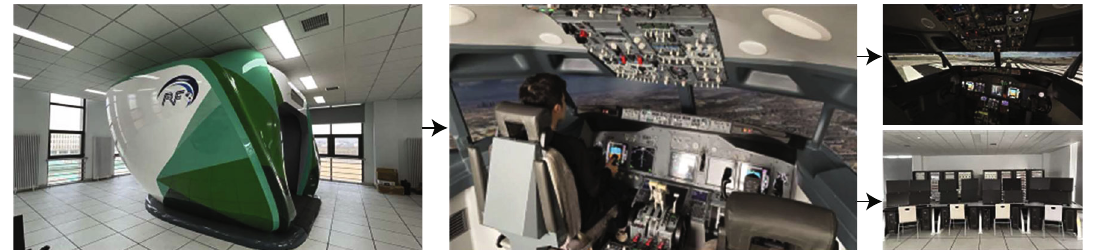
Figure 4: DECO fl ight simulator used for dynamic interaction data acquisition.